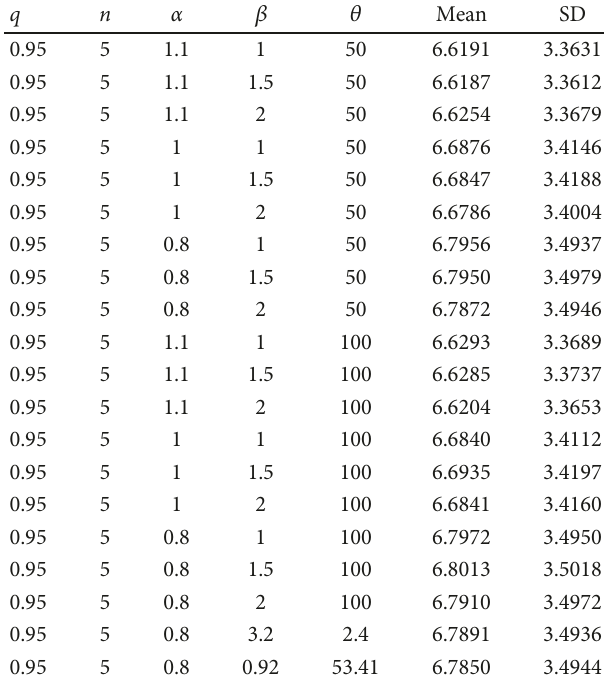
Table 1: Mean and standard deviation at di ff erent